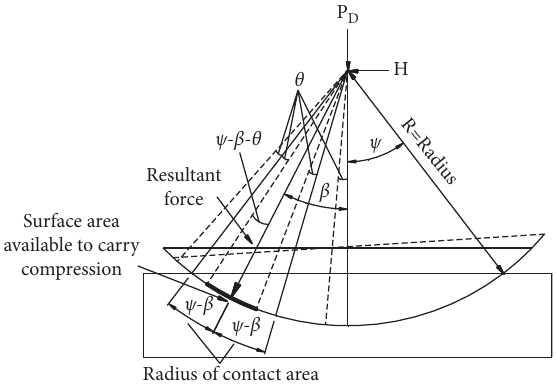
Figure 4: Force distribution of a spherical bearing.